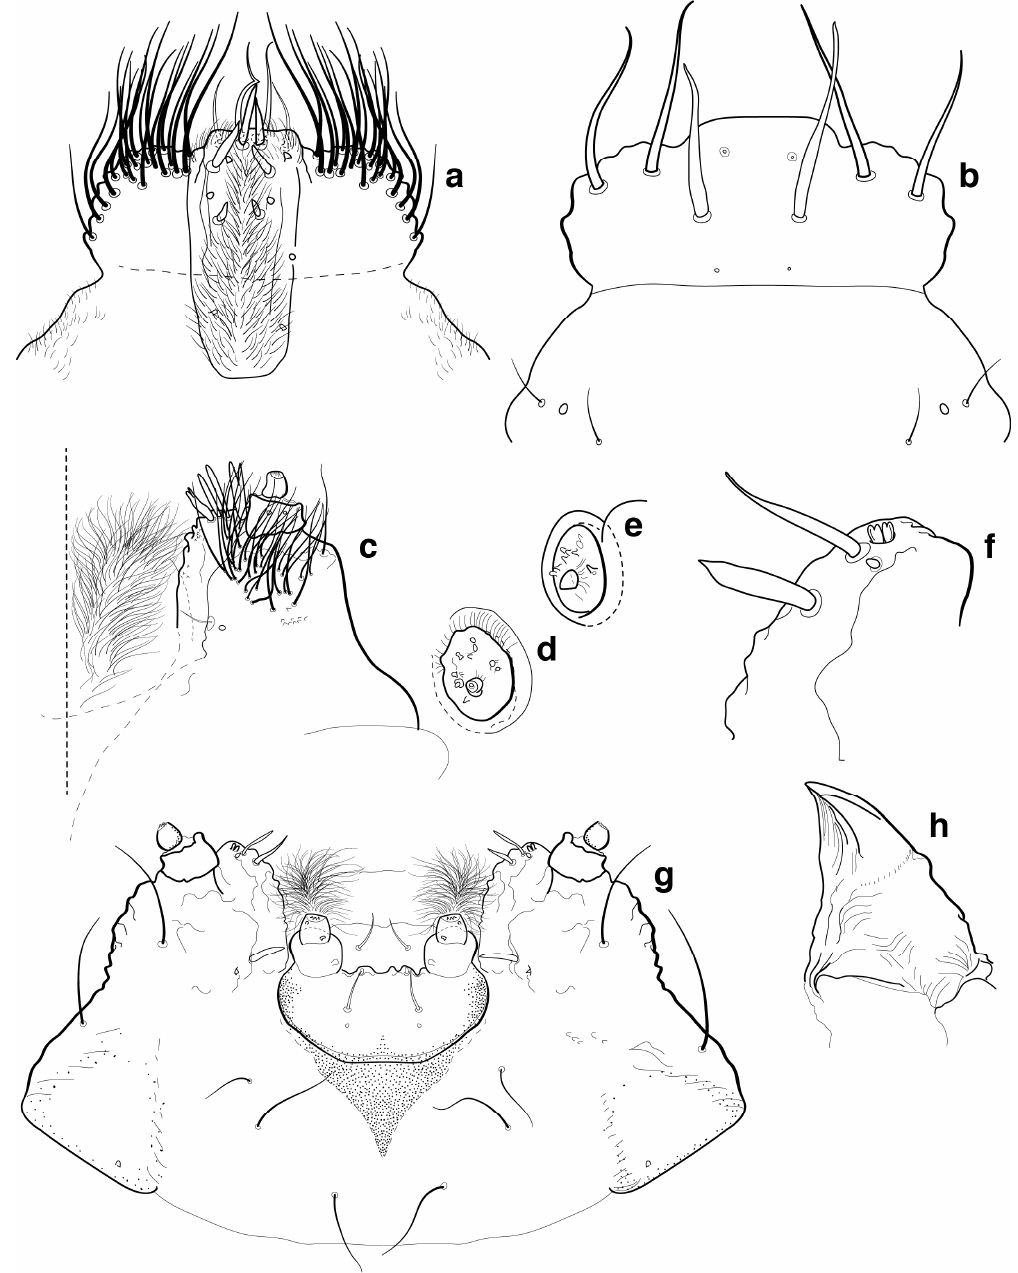
Figure 58. Cyrtotrachelus thompsoni mouthparts: ( a ) epipharynx; ( b ) clypeus and labrum; ( c ) detail of hypopharynx, mala, and maxillary palp, dorsal view; ( d ) antenna, anterior view; ( e ) antenna, oblique lateral view; ( f ) detail of mala, ventral view; ( g ) labio-maxillary complex, ventral view; and ( h ) mandible.